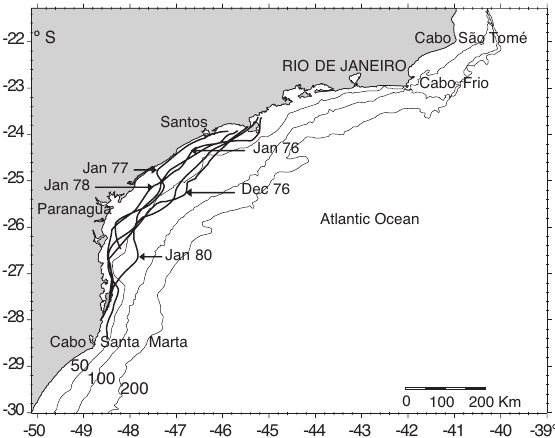
F IG . 3. – The SACW front delineated by the 18 ºC bottom isotherm, from cruises FINEP II (01/76), FINEP V (12/76), FINEP VI